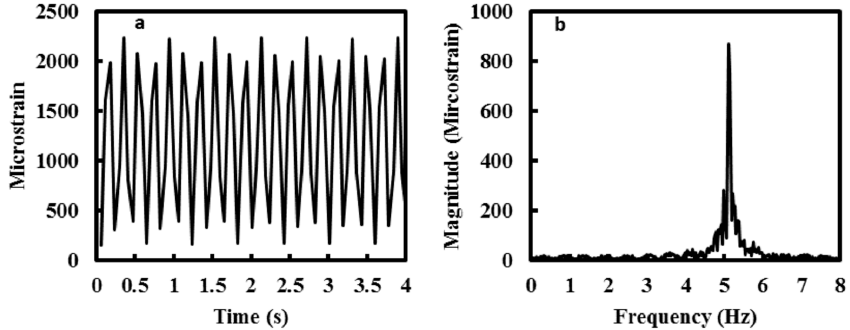
Figure 6. ( a ) Time series (4 s) of the strain measurement at 2000 με loading regime; and ( b ) Fast Fourier Transform (FFT) of the time series.